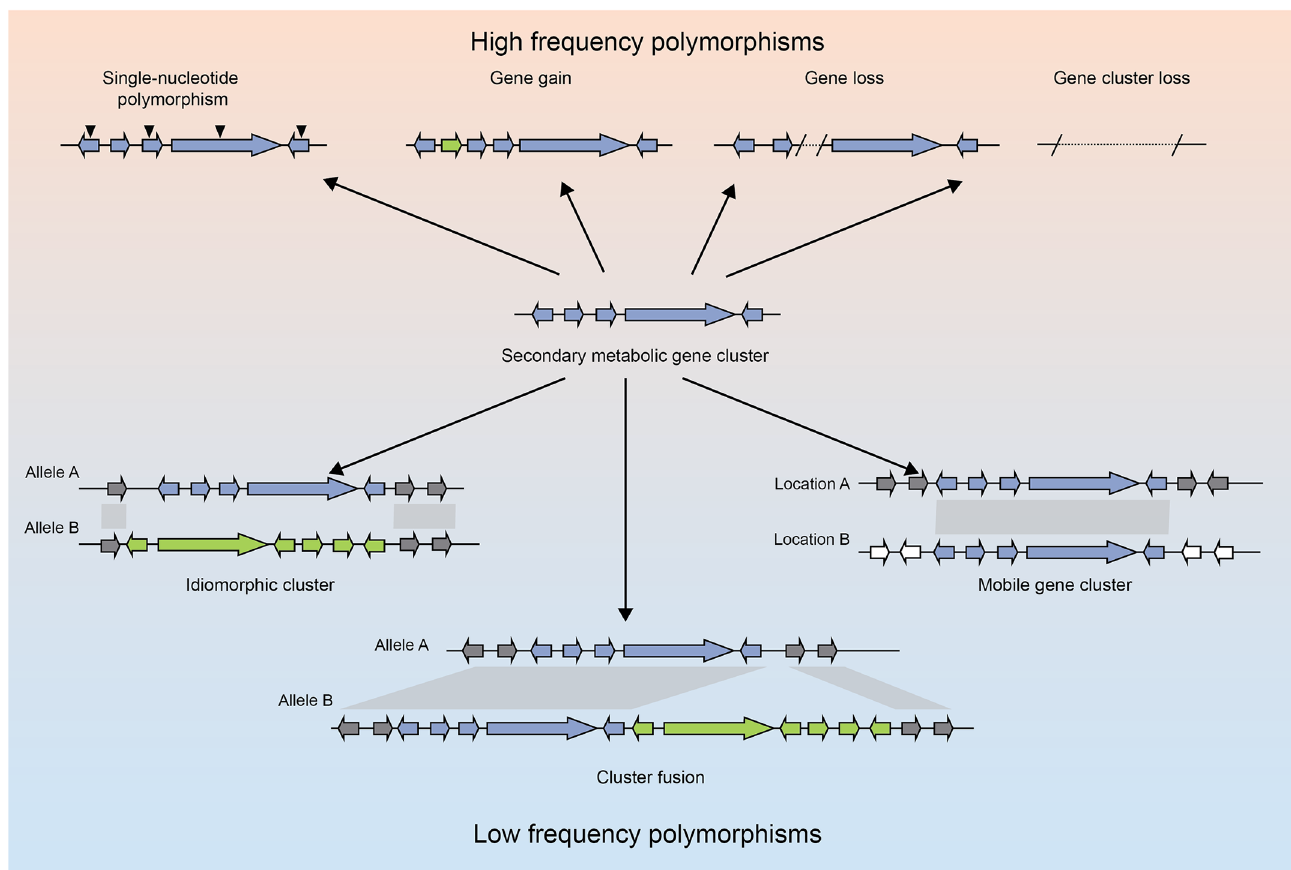
Fig 6. Types and frequencies of all SM gene cluster variants within A . fumigatus . SM,